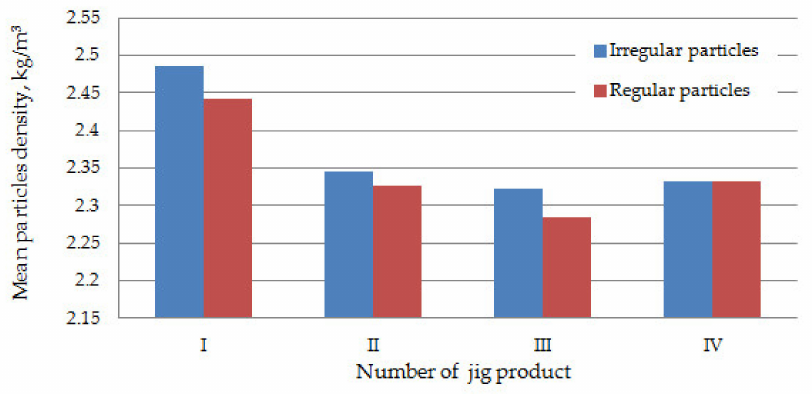
Figure 7. Distribution of the mean particle density in the jigging